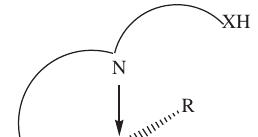
Table 2 13 C NMR spectral data ( δ , ppm) of the ligands (L 1 H Compound